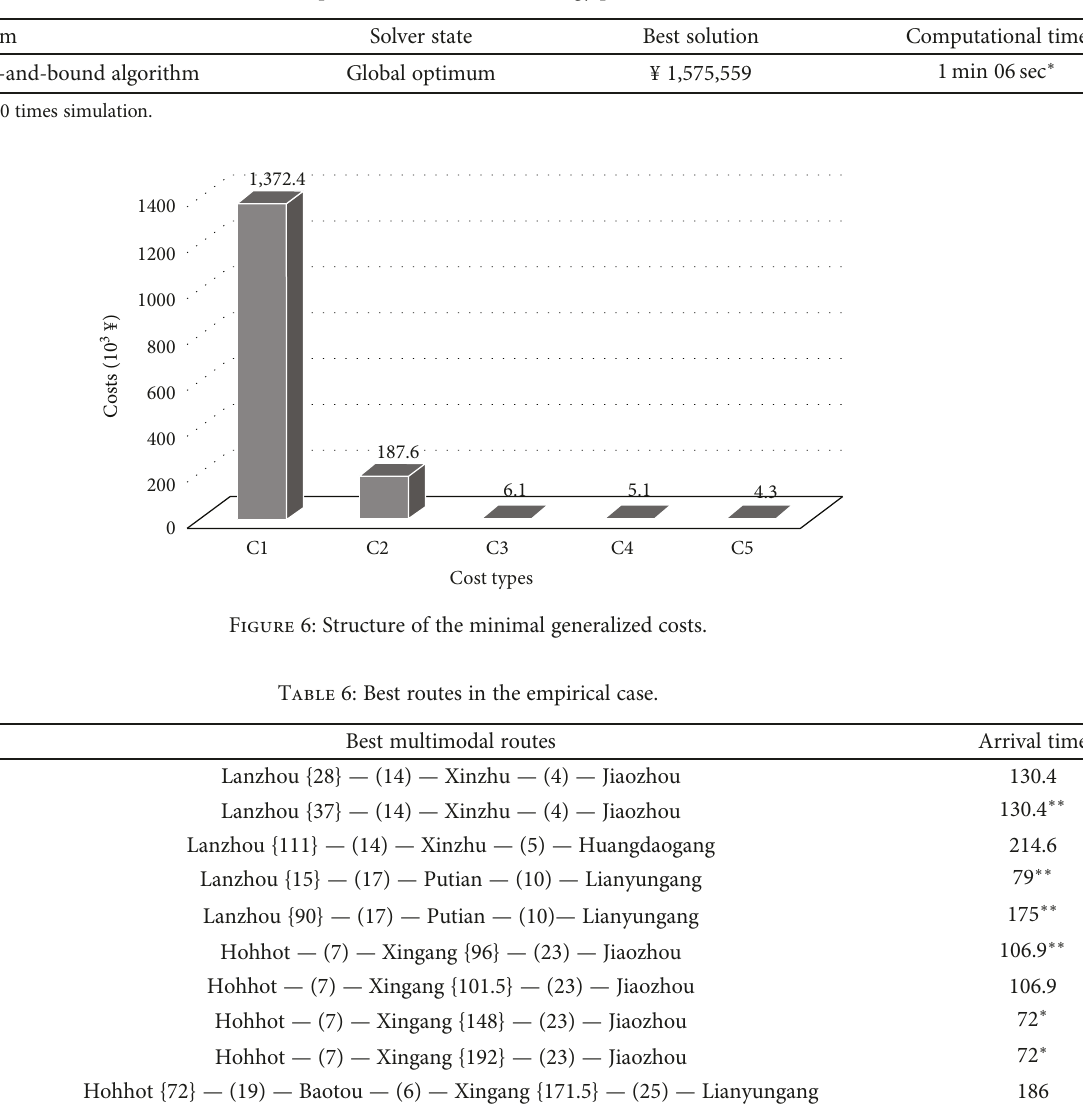
Table 5: Optimization result and strategy performance.